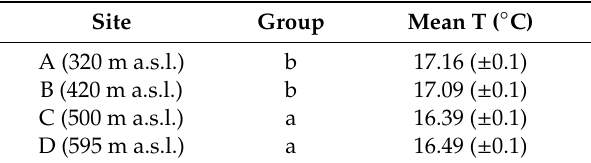
Table 1. Results of the post hoc test used to assess the di ff erences in hourly temperature ( ◦ C) between sites for the growing season of 2018 (15 May to 4 September). “Group” letters identify significantly ( p < 0.05) di ff erent groups, where “a” is the group with the lower value. Corresponding mean temperature ( ◦ C) values for the growing season are also shown for each site. Values in brackets represent the standard error (S.E.).